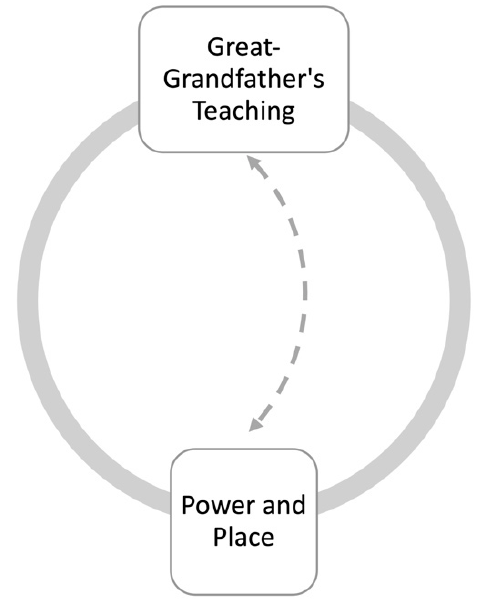
Figure 1. Connecting meaning on (my) doctoral process.